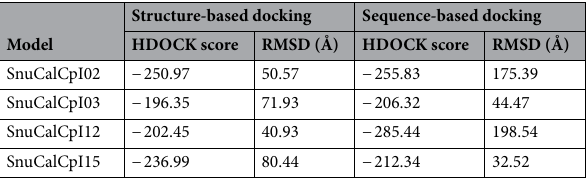
Table 2. Quantitative docking scores for cathepsin L-SnuCalCpI